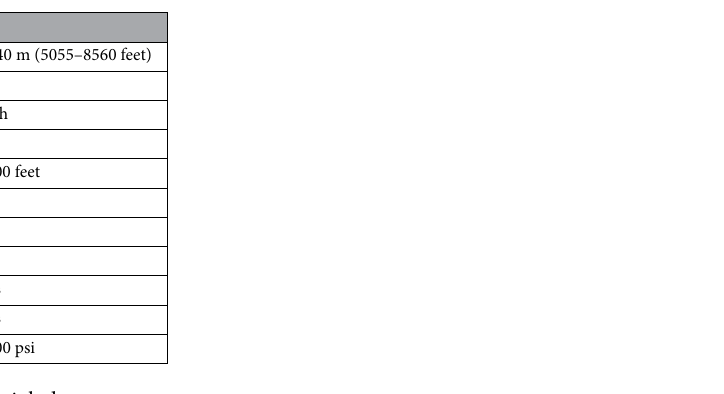
Table 16. Nitrogen shooting job